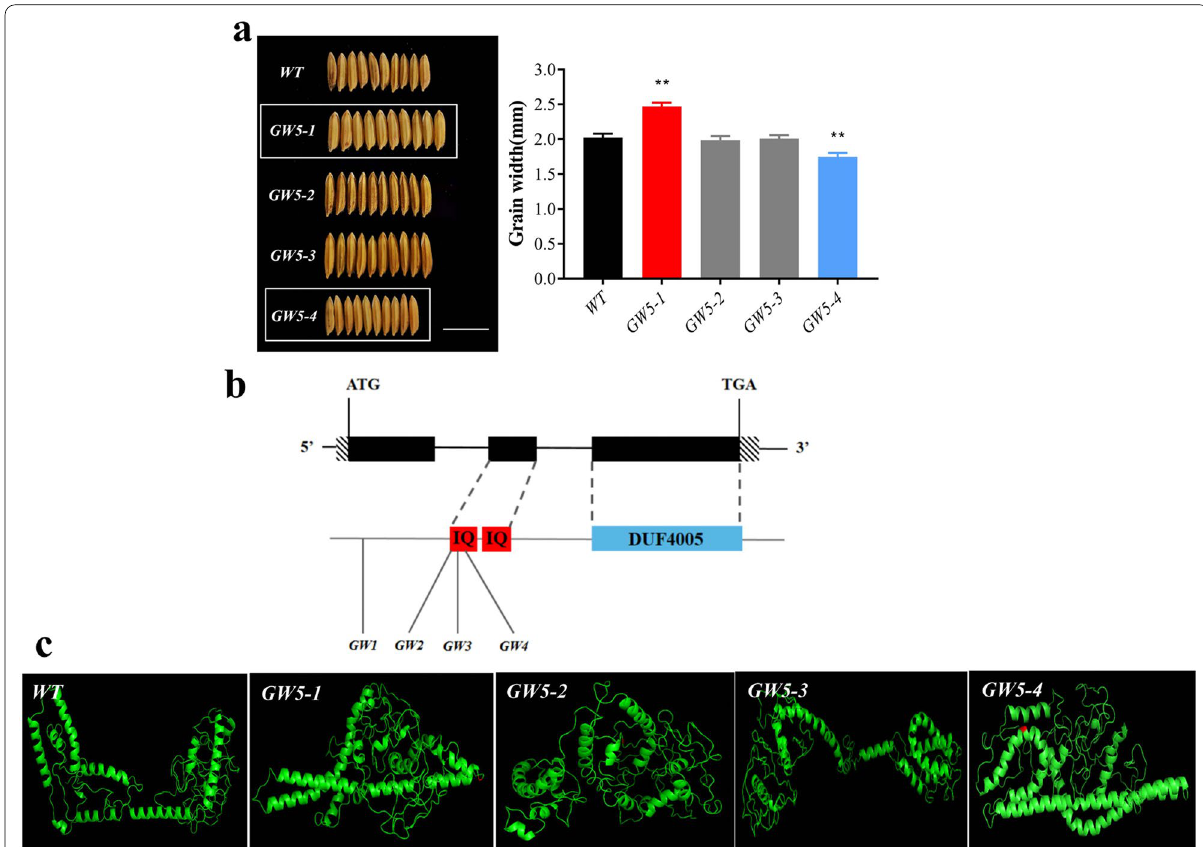
Fig. 6 a Grain width and WT alignment of four GW5 mutants. Scale bars structures of GW5 mutants (differential structures in red)